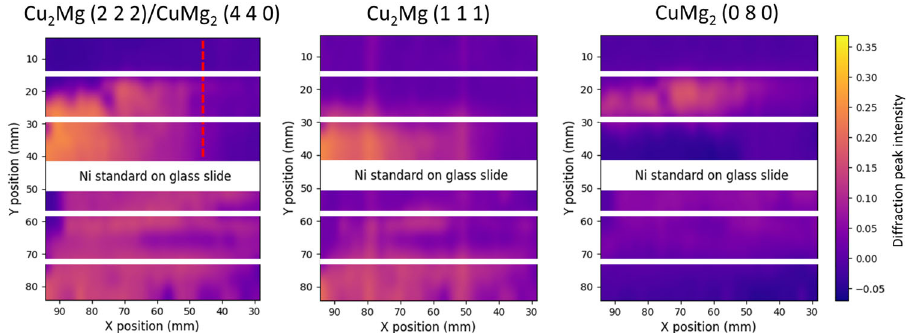
Fig. 5 Selected diffraction peaks and interpolated diffraction peak intensities from Cu 2 Mg (1 1 1), CuMg 2 (0 8 0), and Cu 2 Mg (2 2 2) overlapped with CuMg 2 (4 4 0). The white color lines separate the regions with different dealloying